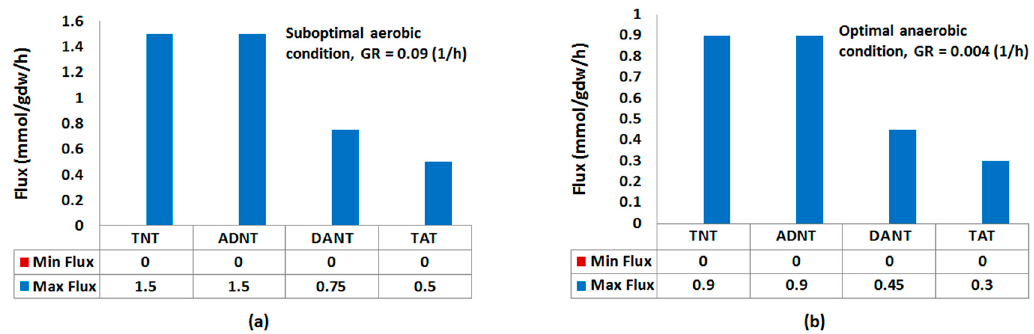
Figure 2. Minimum and maximum feasible TNT uptake and reduced metabolite formation rates through activity of nitroreduction pathway under ( a ) aerobic and ( b ) anaerobic conditions for a glucose uptake rate of 250 mg/gdw/h.